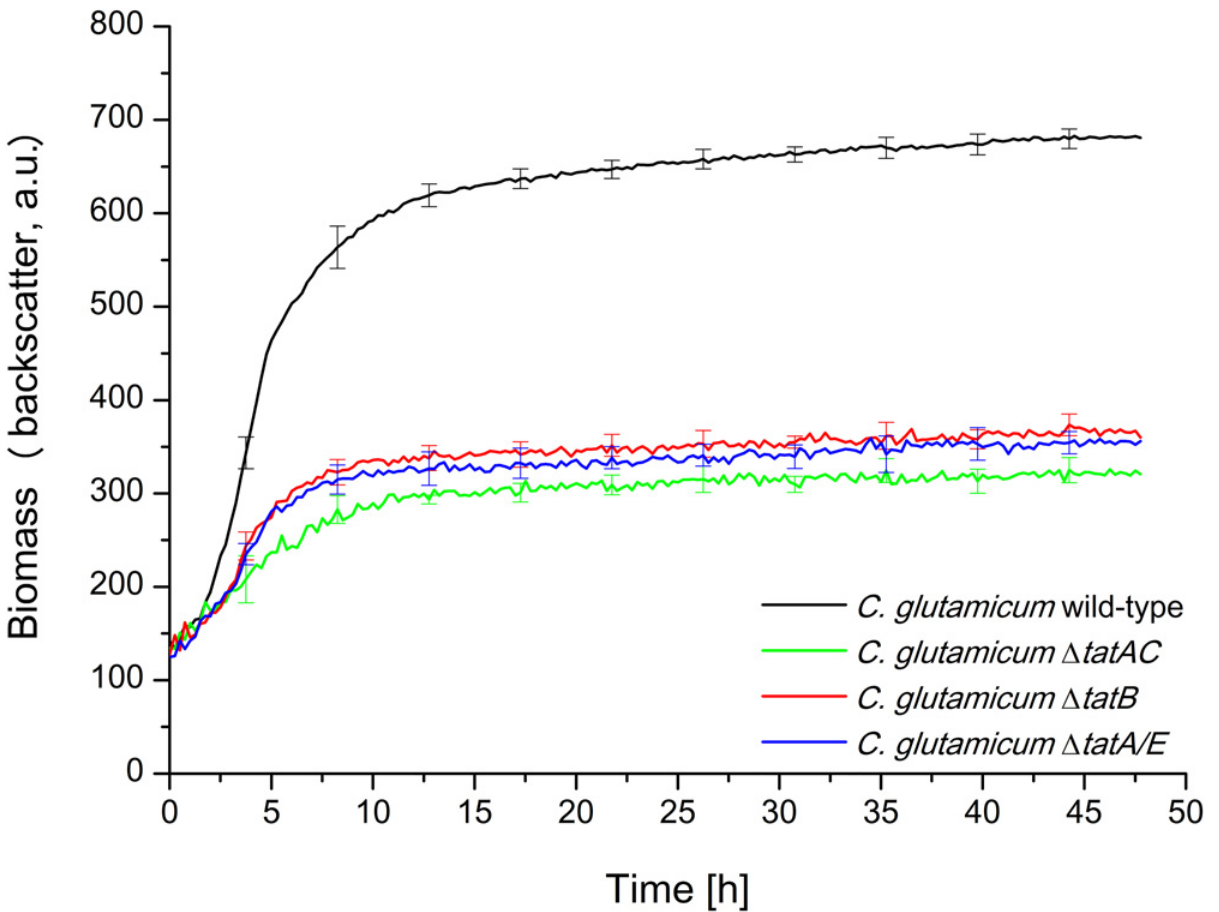
Fig 1. Growth phenotype of C . glutamicum ATCC13032 wild-type, Δ tatAC , Δ tatA/E , and Δ tatB mutants. Cells were inoculated to an OD 600 of 0.5 in 750 μ l BHIS medium and cultivated in 48-well FlowerPlates in a BioLector system for 48 h at 30°C, 1100 rpm under constant 85% relative humidity. Growth of the respective C . glutamicum strains, as indicated in the figure, was monitored as backscattered light (620 nm; signal gain factor 20) in 15 min intervals. The growth curves show one representative experiment of three independent biological replicates. Standard deviations are given for 10 selected time points. a.u.: arbitrary